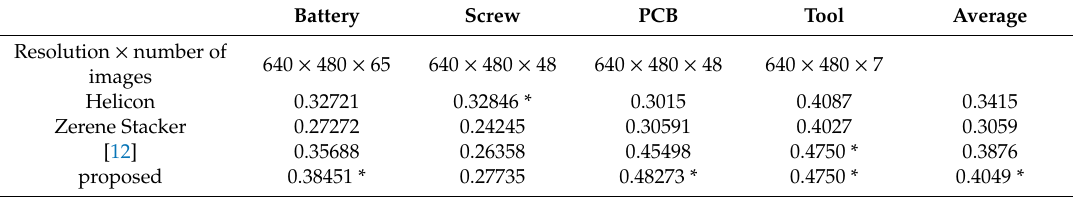
Figure 12. Comparison of results by using Equation (4) ( a1 – d1 ) and Equation (2) proposed ( a2 – d2 ). Table 1. Quality assessment for image fusion results. The “*” represents the winner for each case of image stack.